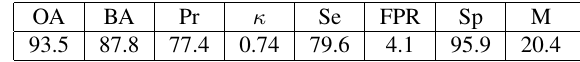
Table 2. Evaluation of the classification results in percentage: Overall accuracy (OA), balanced accuracy (BA), precision (Pr), kappa ( κ ), sensitivity (Se), false positive rate (FPR), specificity (Sp), miss rate